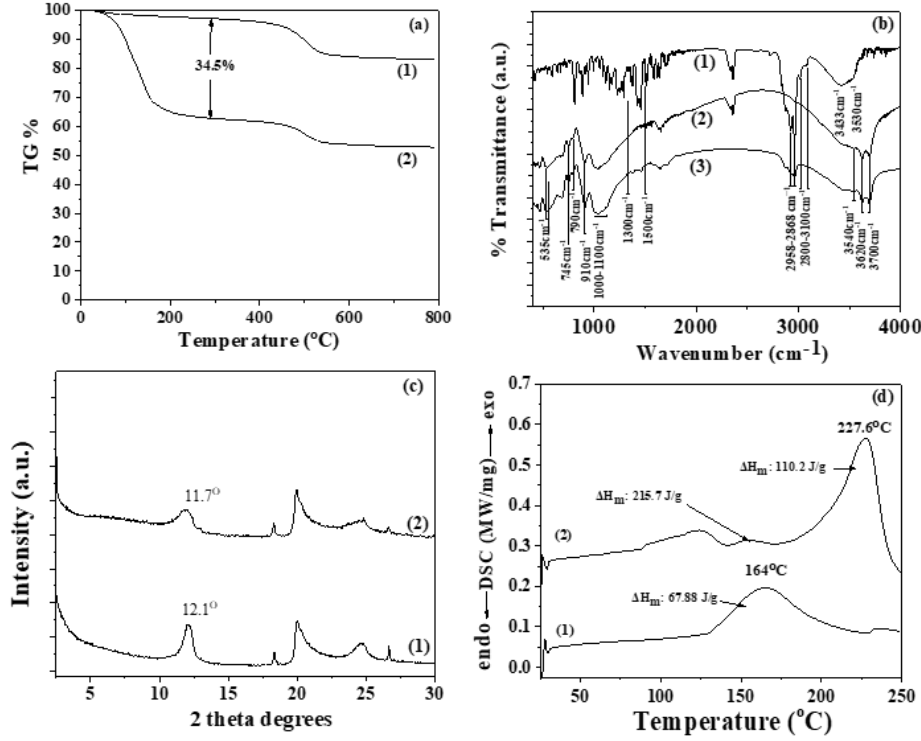
Figure 1. ( a ) TG plots of (1) pure HNT and (2) TO@HNT hybrid nanostructure, ( b ) FTIR plots of (1) TO, (2) pure HNT, and (3) TO@HNT hybrid nanostructure, ( c ) XRD plots of (1) pure HNT, and TO@HNT hybrid nanostructure, and ( d ) DSC plots of pure HNT (line 1) and modified TO@HNT (line 2) .